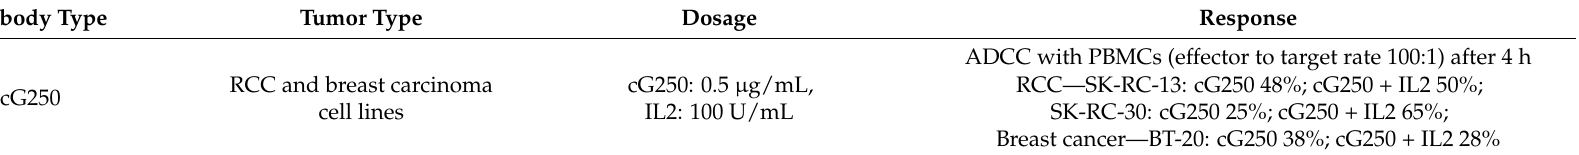
Table 1. Anti-CAIX monoclonal antibodies-based preclinical studies reporting antitumor